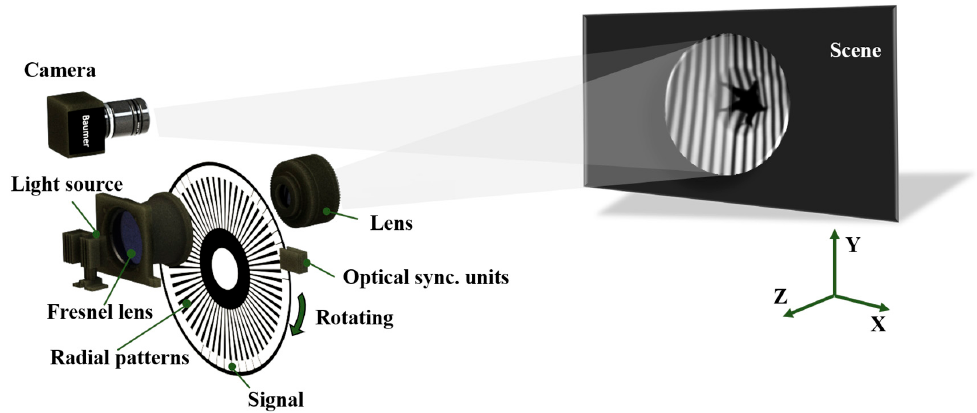
Figure 3. Schematic diagram of our proposed mechanical projection system.